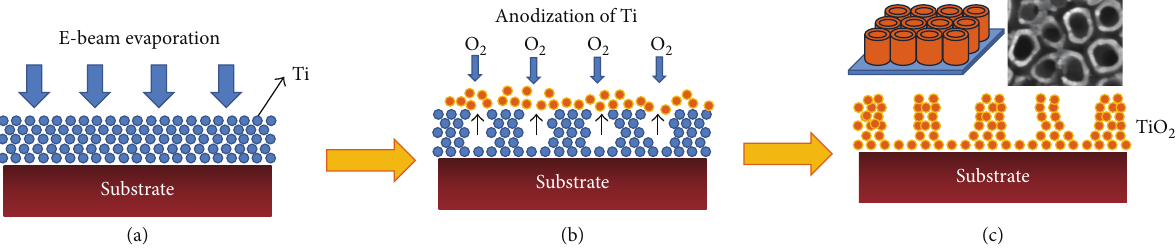
Figure 1: A schematic diagram for the preparation of TNAs: (a) deposition of Ti thin film on quartz substrate using E-beam evaporation method, (b) anodic oxidation of Ti thin film, and (c) formation of TNAs.